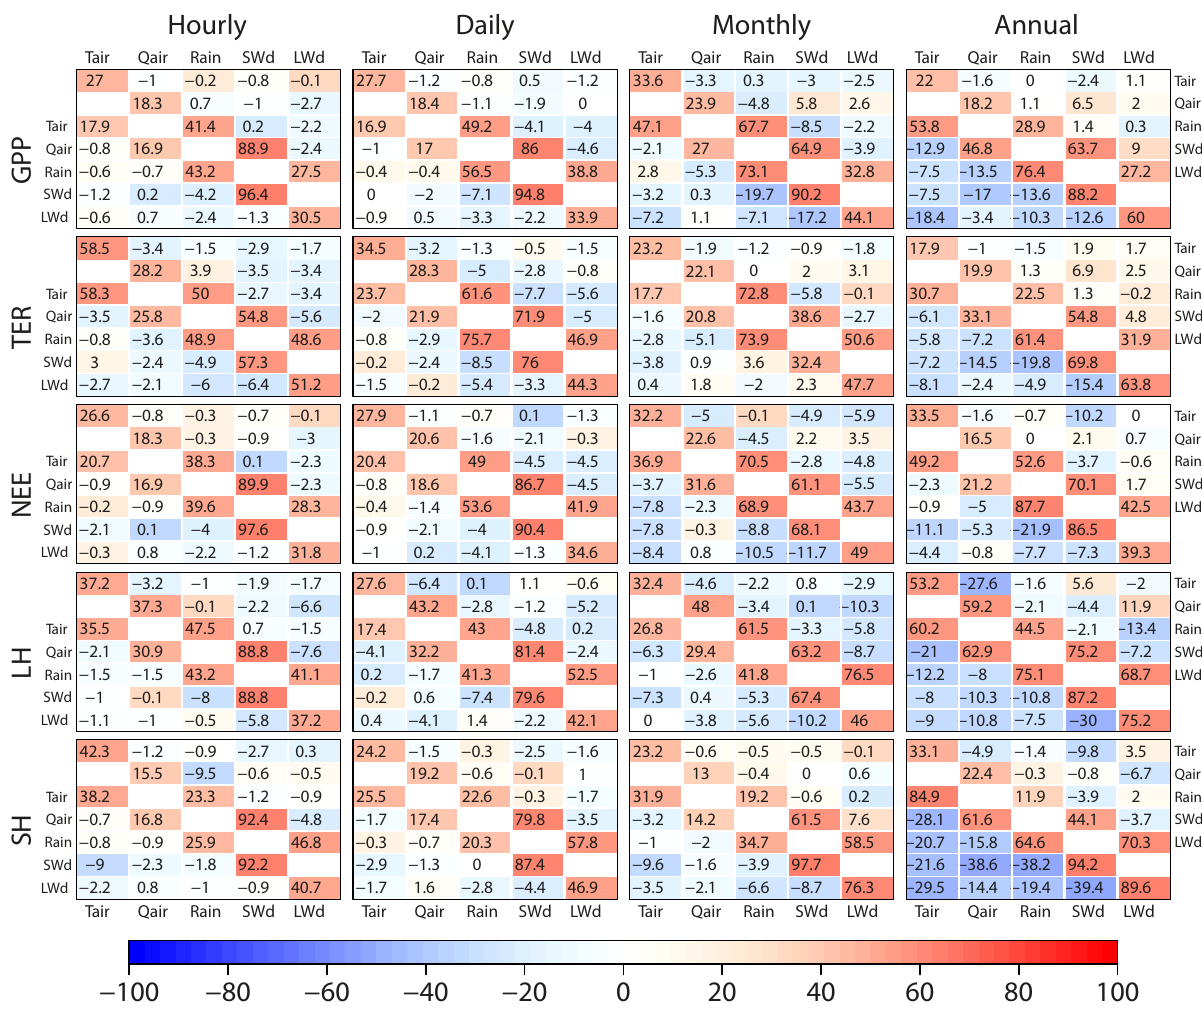
Fig. 10. Summary of forcing errors caused by meteorological drivers and the covariance between the meteorological variables. Diagonal terms: contribution of each meteorological variables; non-diagonal terms: contribution of pairs of meteorological variables. The upper-right triangle is calculated based on annual flux and the lower-left diagonal at peak growing season. See text for the details of